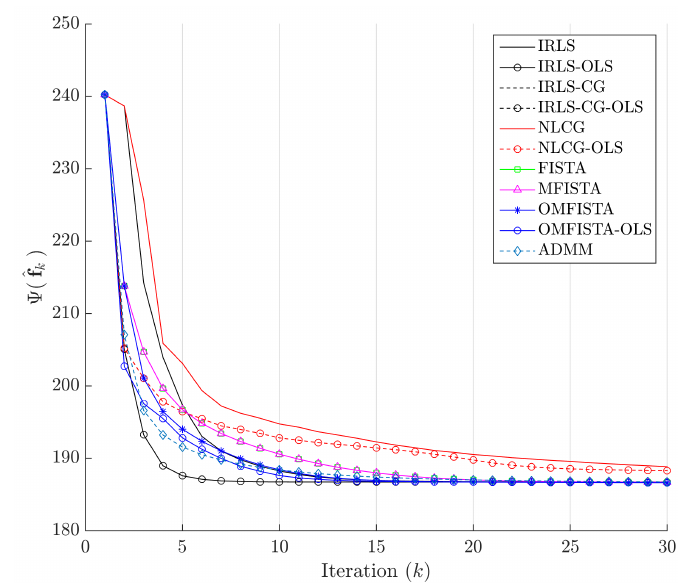
Figure 22. Cost function Ψ ( ˆ f k ) versus iteration number k —Distinct real dataset.